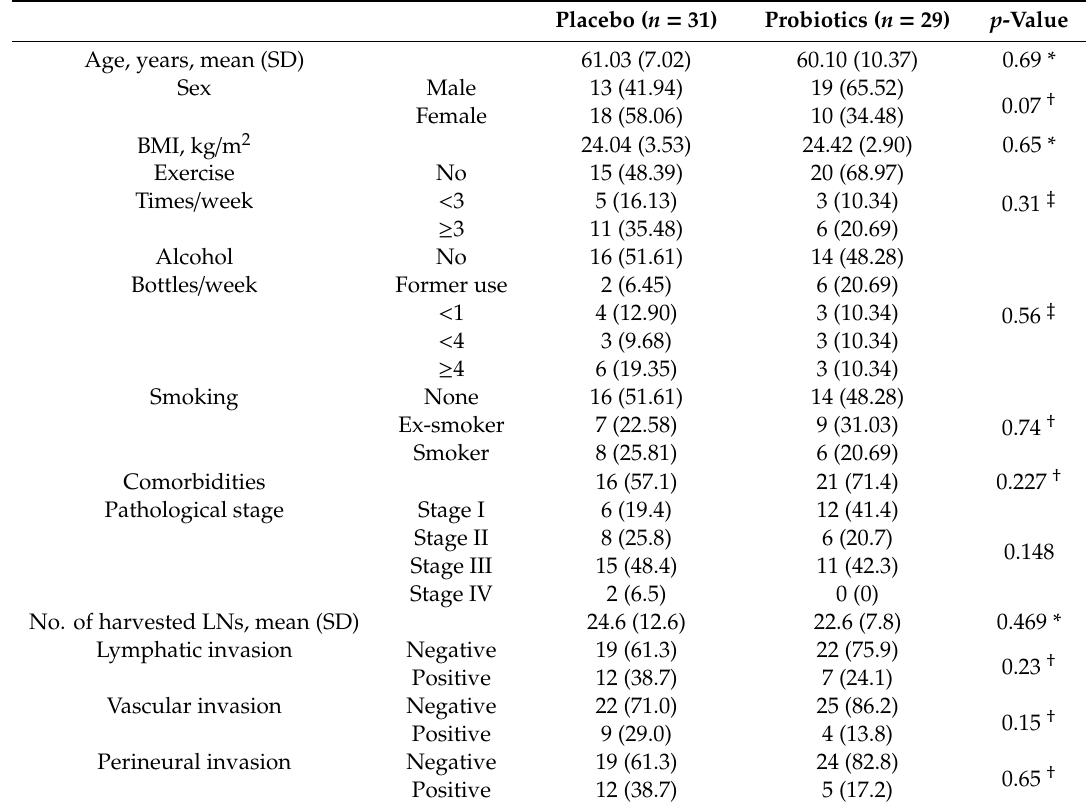
Table 1. Patient demographic and pathology